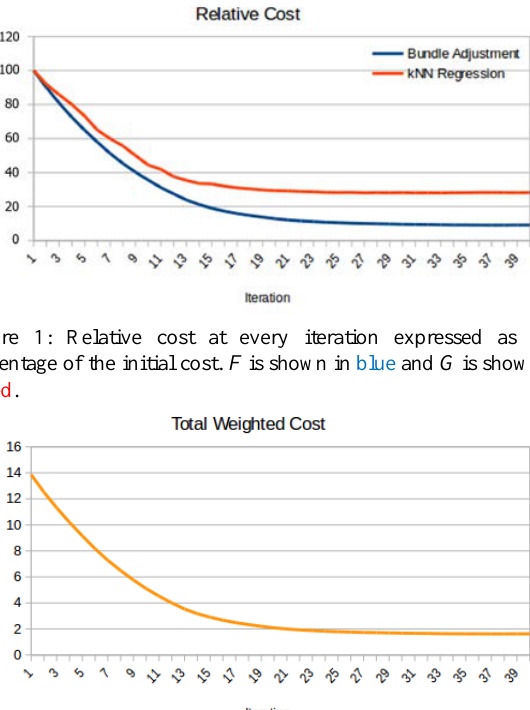
Figure 2: Weighted average cost of both the bundle adjustment and kNN regression